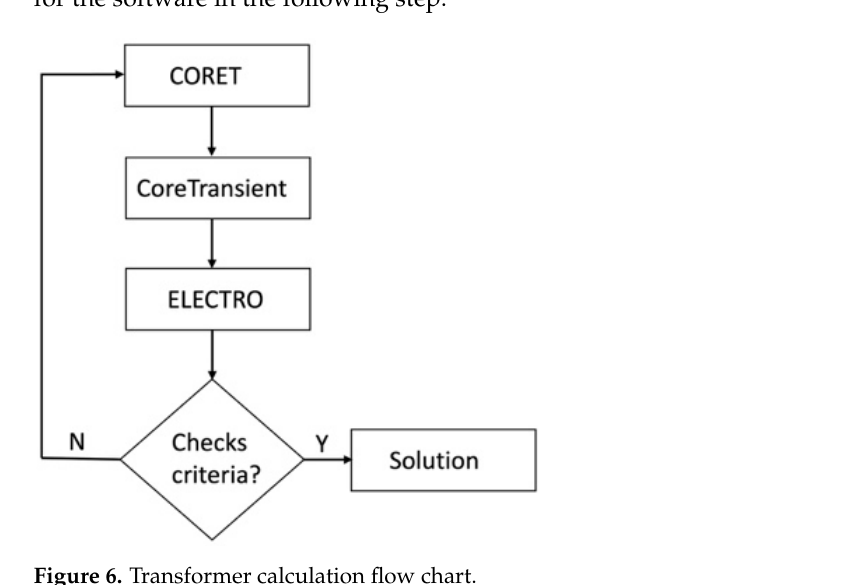
Figure 6. Transformer calculation flow chart.